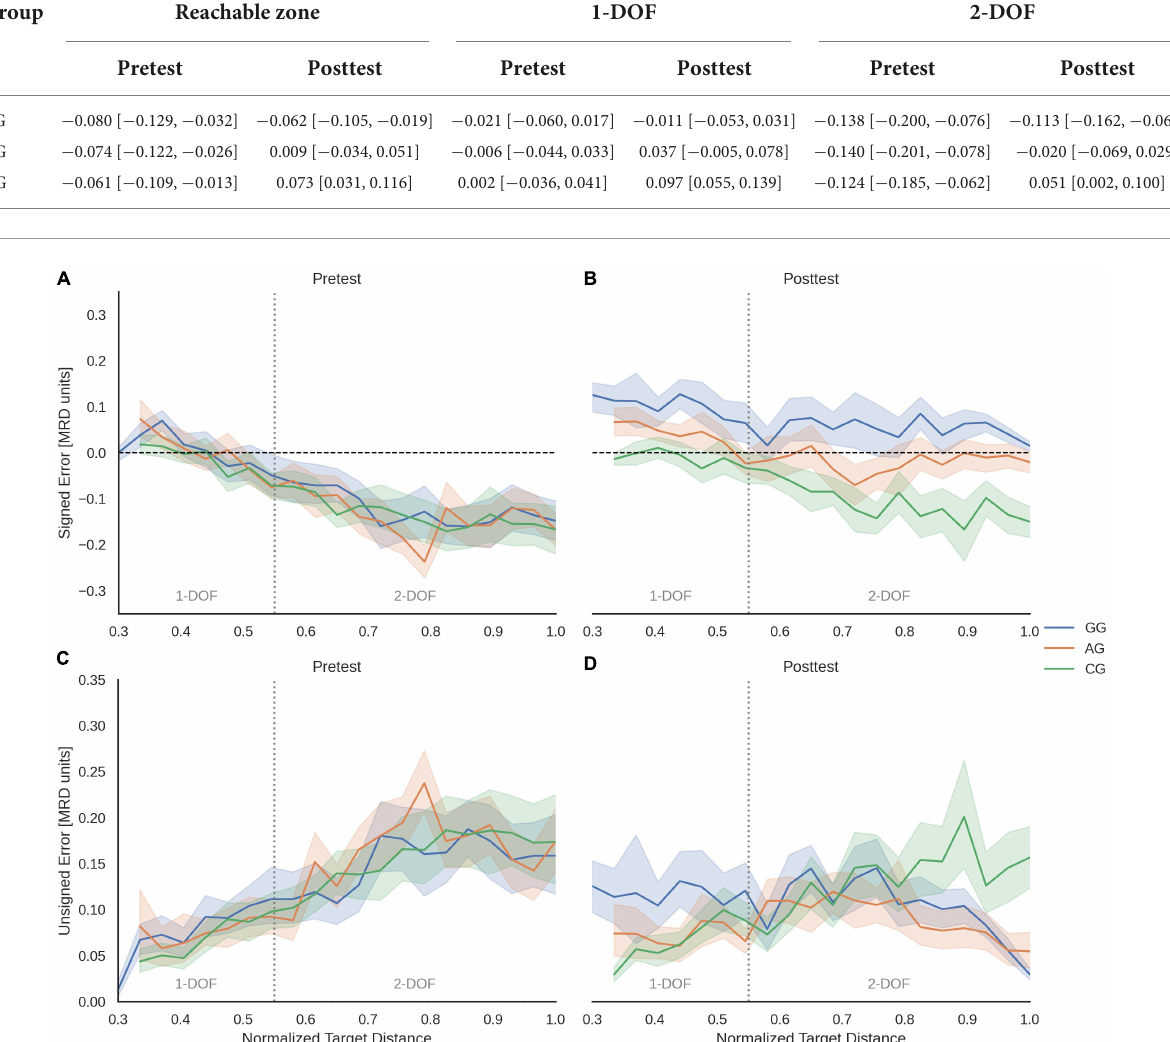
TABLE 2 Mean values and 95% confidence intervals (in square brackets) of SE according to regions, group, and phase. Group